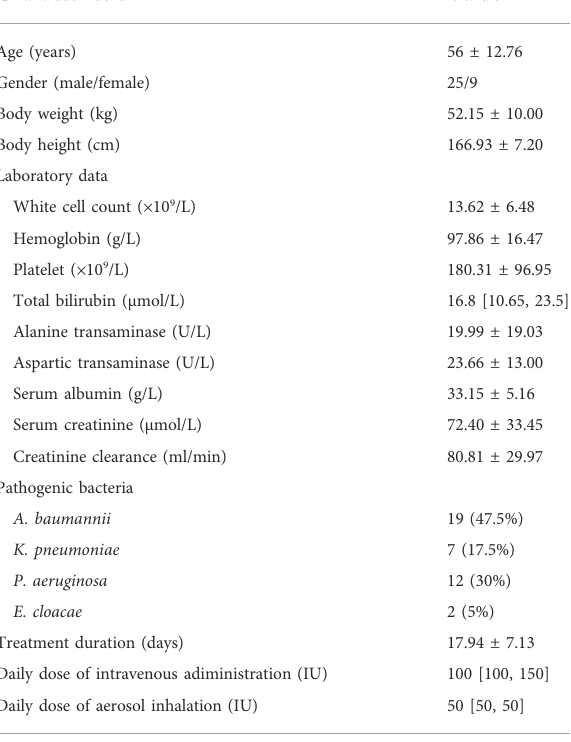
TABLE 1 Clinical characteristics of recipients with lung transplantation. Characteristic